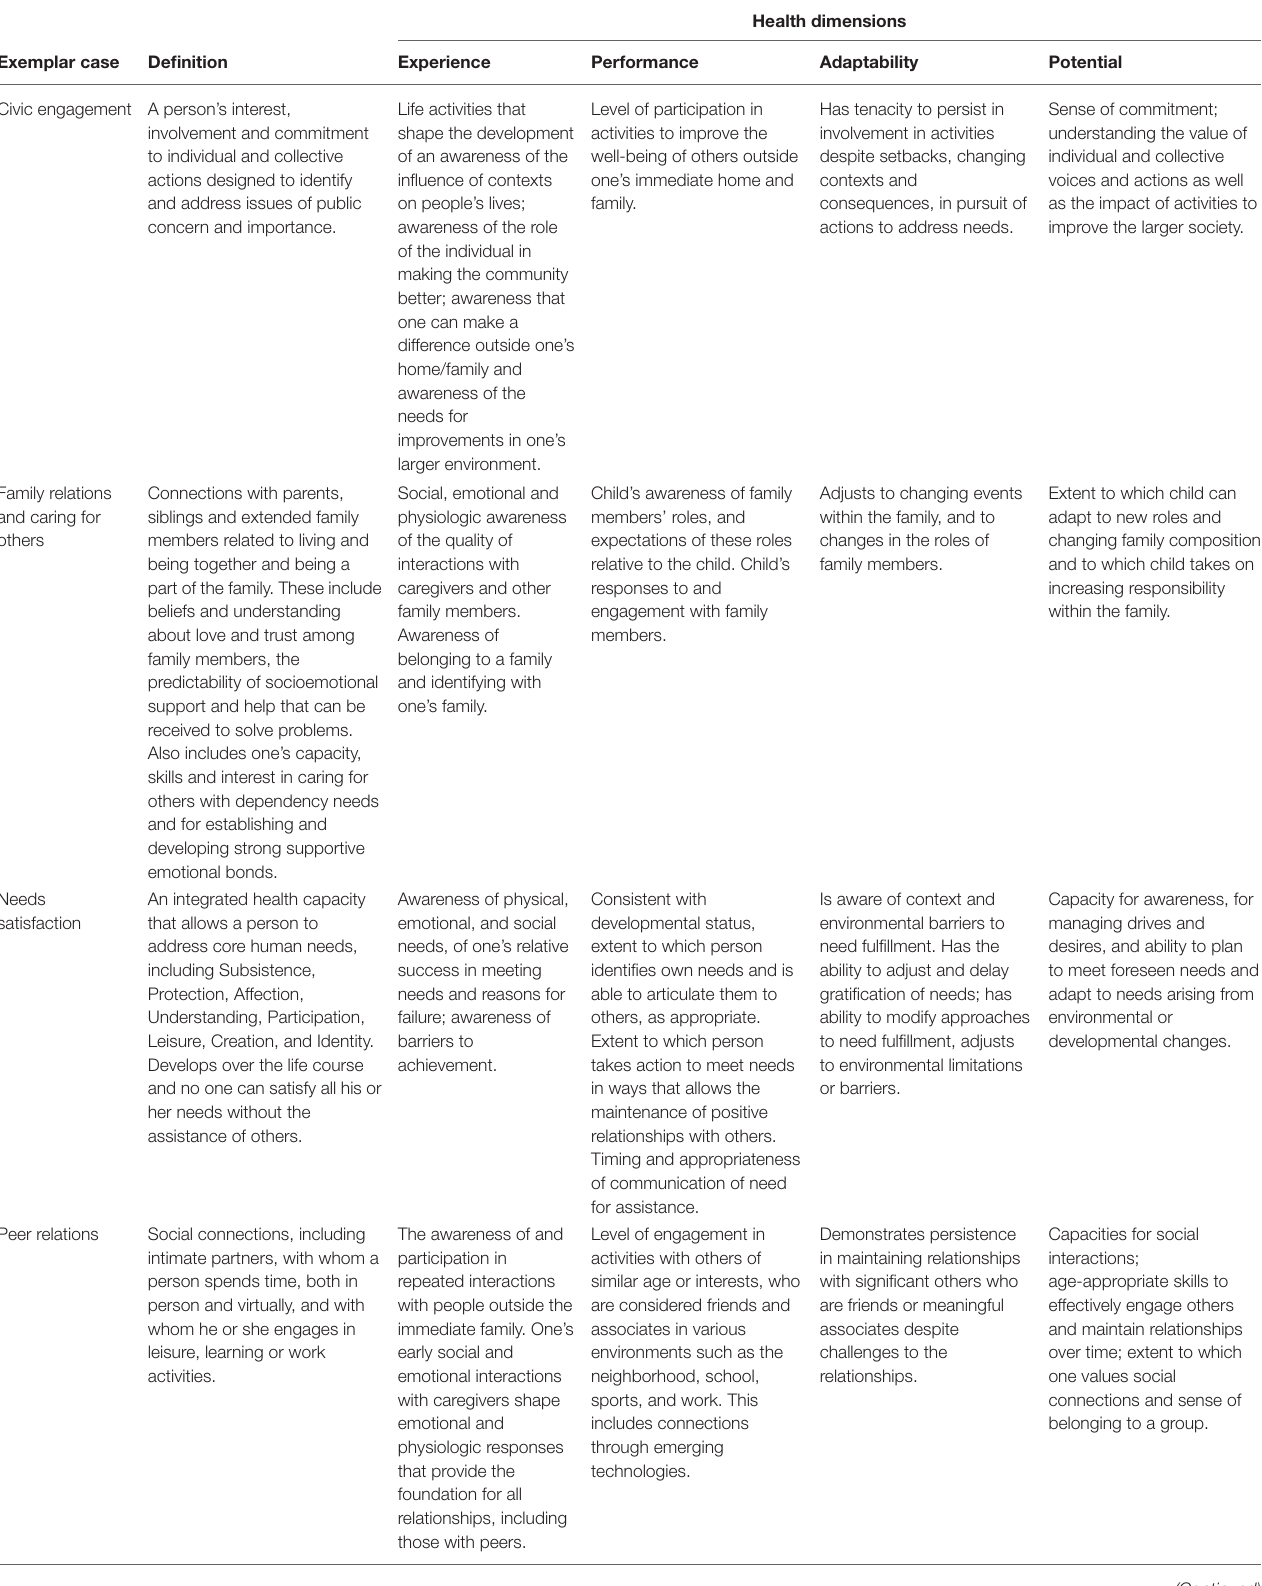
TABLE 1 | Exemplar case definitions and description by health